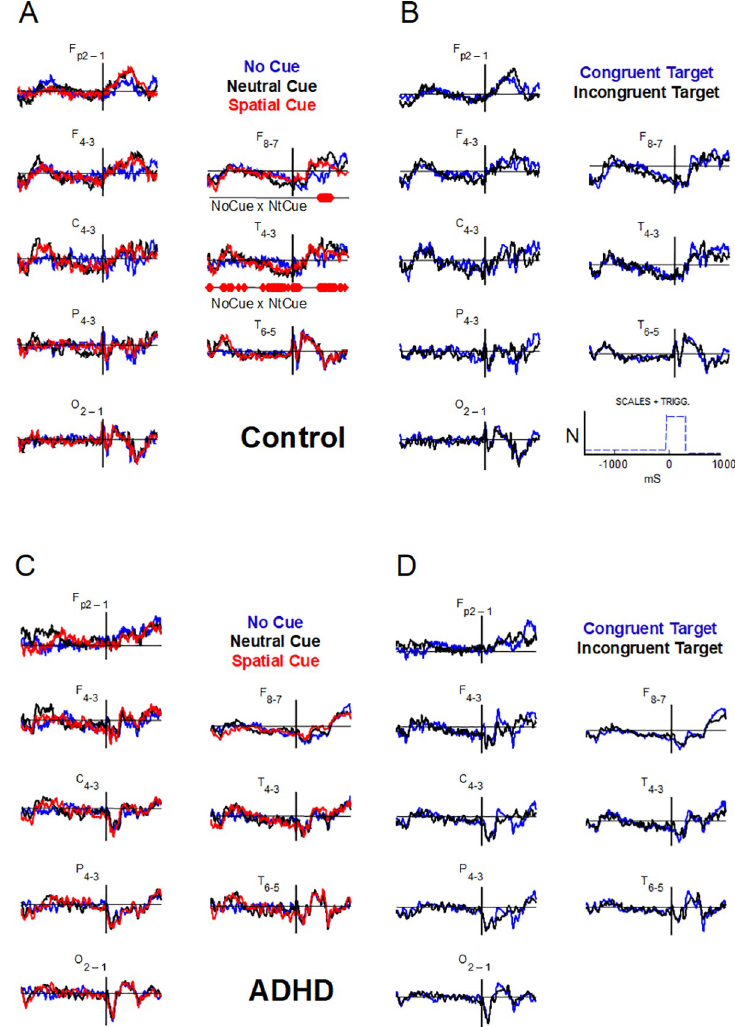
Fig 4. Comparisons of interhemispheric differences in ANT-related potentials between ANT conditions. Each wave is the respective interhemispheric difference (right minus left) of ANT-related potentials for No cue (NoCue, blue), Neutral cue (NtCue, black), and Spatial cue (red) conditions, in A and C, and for Congruent (blue) and Incongruent (black) target conditions, in B and D. Point-to-point statistical comparisons (FDR corrected) between consecutive conditions (NoCue x NtCue, NtCue x SpCue, congruent x incongruent, related to alerting, orienting, and executive networks, respectively). Control groups in A and B, ADHD groups in C and D. Amplitudes are normalized (positive values above abscissae). ‘NoCue x NtCue’–comparison that showed significant differences. See Fig 2 for channel labeling.